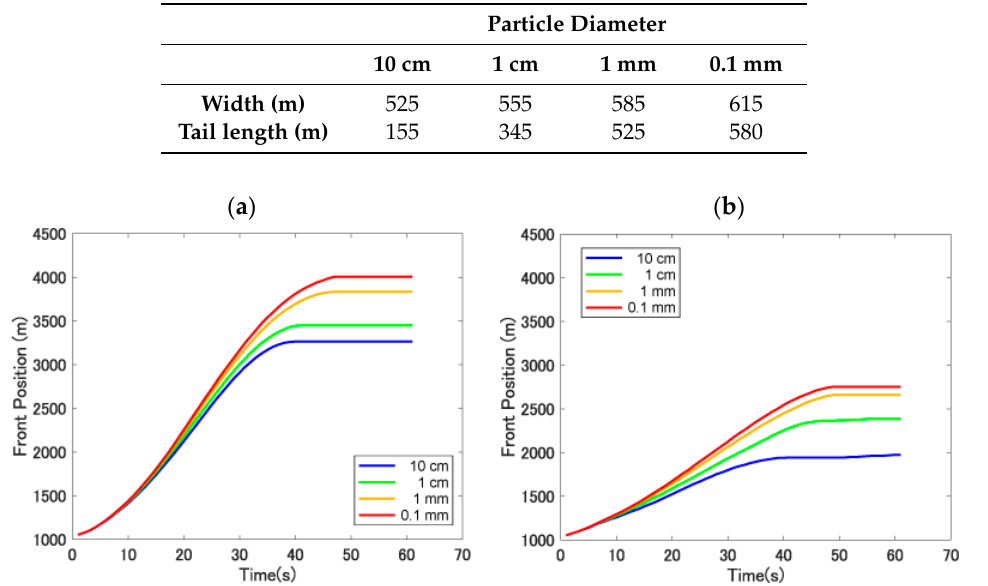
Figure 6. A numerically simulated variation of the flow front positions over time. Simulations were implemented for a flow on the ( a ) 47° slope (at the release position) and ( b ) 26° slope (at the release position).